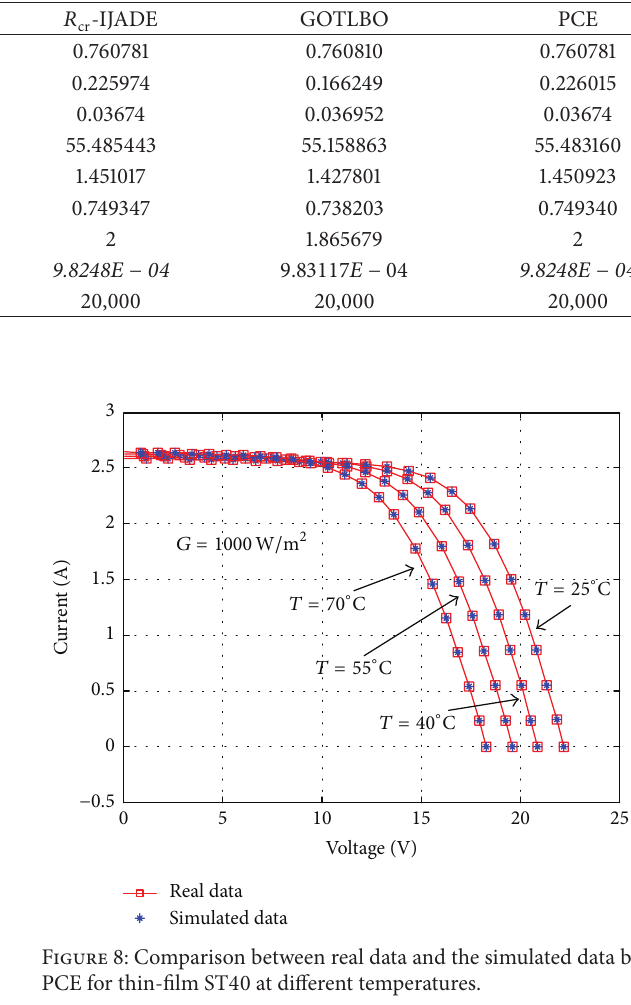
Table 12: Data comparison of the double diode model from the related literature.